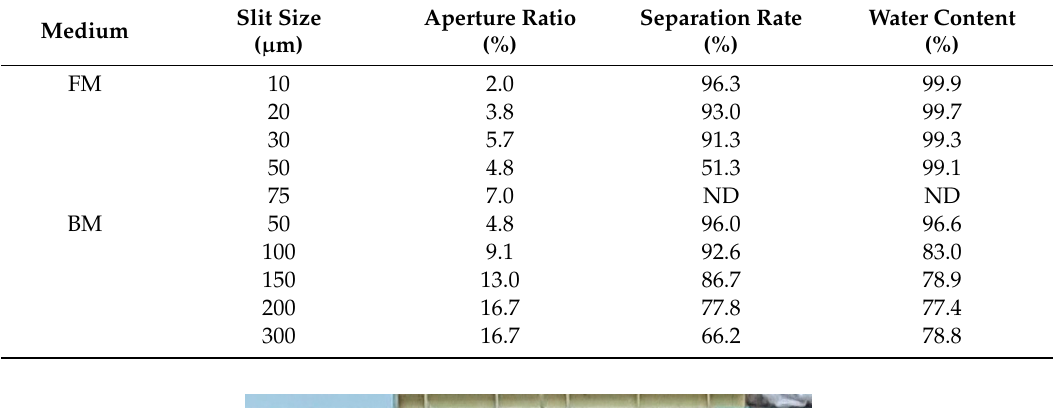
Figure 3. Size distributions of algal colonies cultured in ( A ) the freshwater medium and ( B ) the brackish water medium.